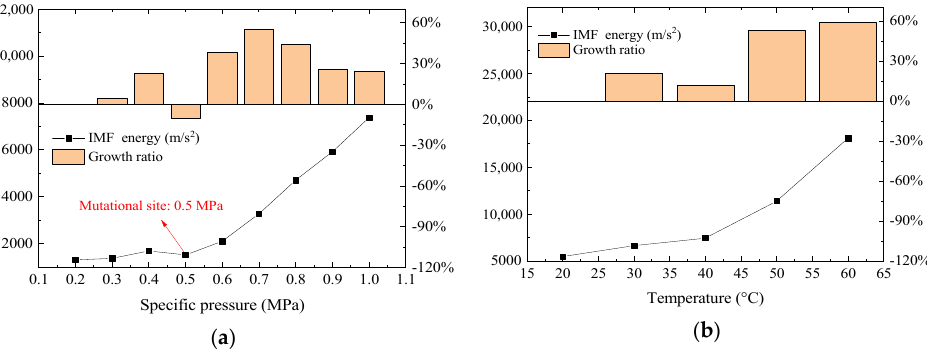
Figure 15. Effect of the specific pressure and temperature on the IMF energy and growth ratio. ( a ) Specific pressure, ( b ) temperature.